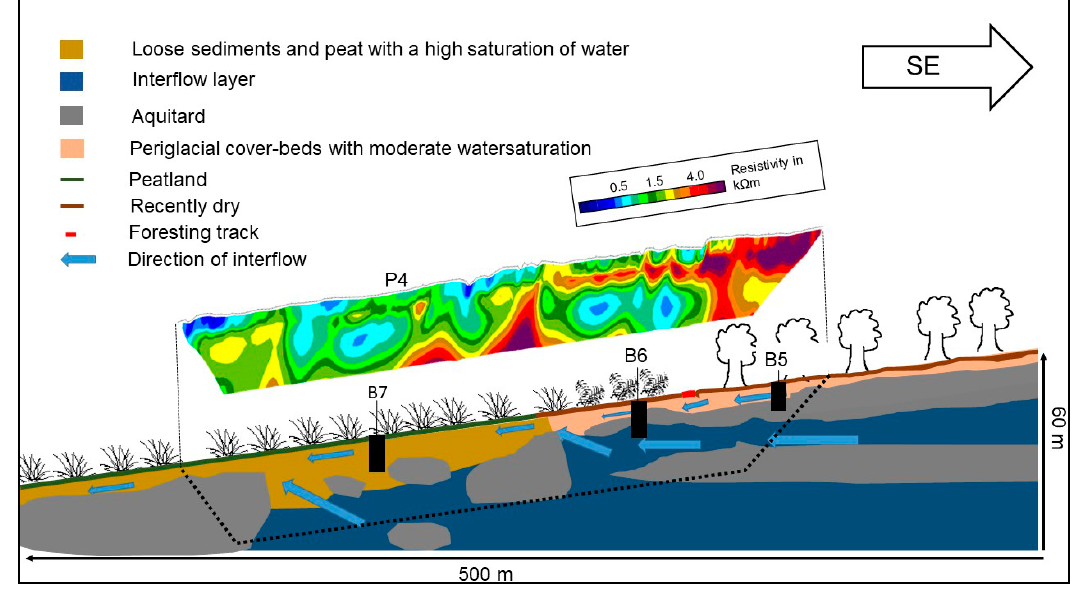
Figure 24. Model3: "Gebranntes Bruch". Figure 14. Model3: “Gebranntes